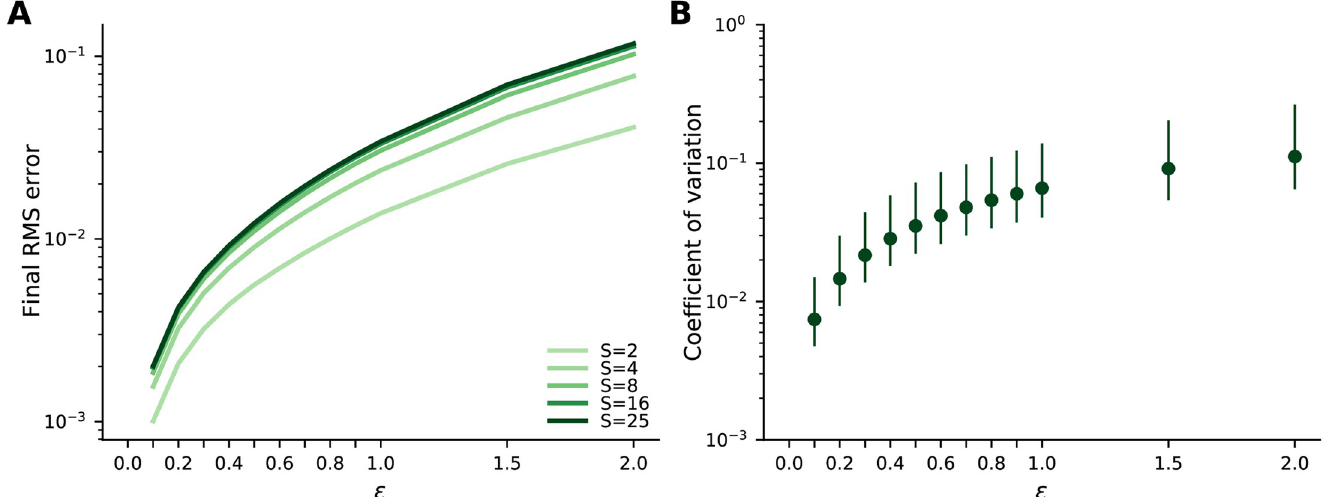
Fig 10. Properties at convergence versus periglomerular leak ε . (A) Mean RMS error at convergence, relative to its initial value, as a function of leak for different numbers of sister cells per glomerulus. The RMS error increases with leak and with the number of sister cells, but never gets very large. Means are computed over 10 different odours and 5 different olfactory bulbs. (B) Median (dots) and inter-quartile range (lines) of the coefficient of variation (CV; standard deviation divided by the mean) of the ratios of sister cell activity at convergence as a function of the leak parameter ε . CVs are computed over the ratios of all unique pairs of 25 sisters in a glomerulus, percentiles are computed over all glomeruli in response to 10 different odours across 5 different olfactory bulbs. Median CVs remain low even for high values of leak. Parameters from Table 1, except for S and ε .